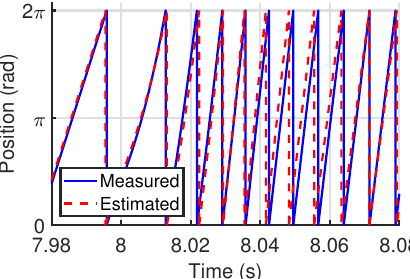
Figure 25. Position magnification under variable speed.